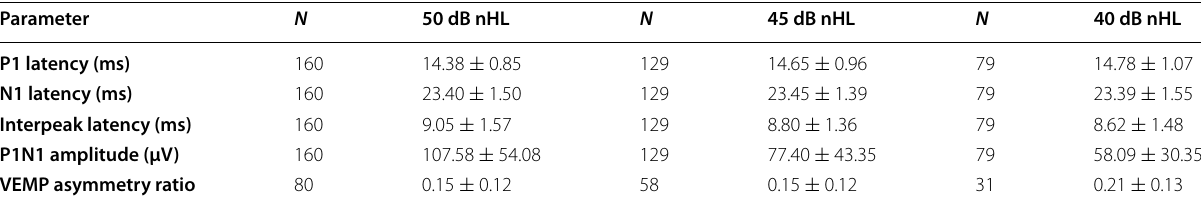
Table 3 Descriptive statistical values of BC cVEMP parameters (mean